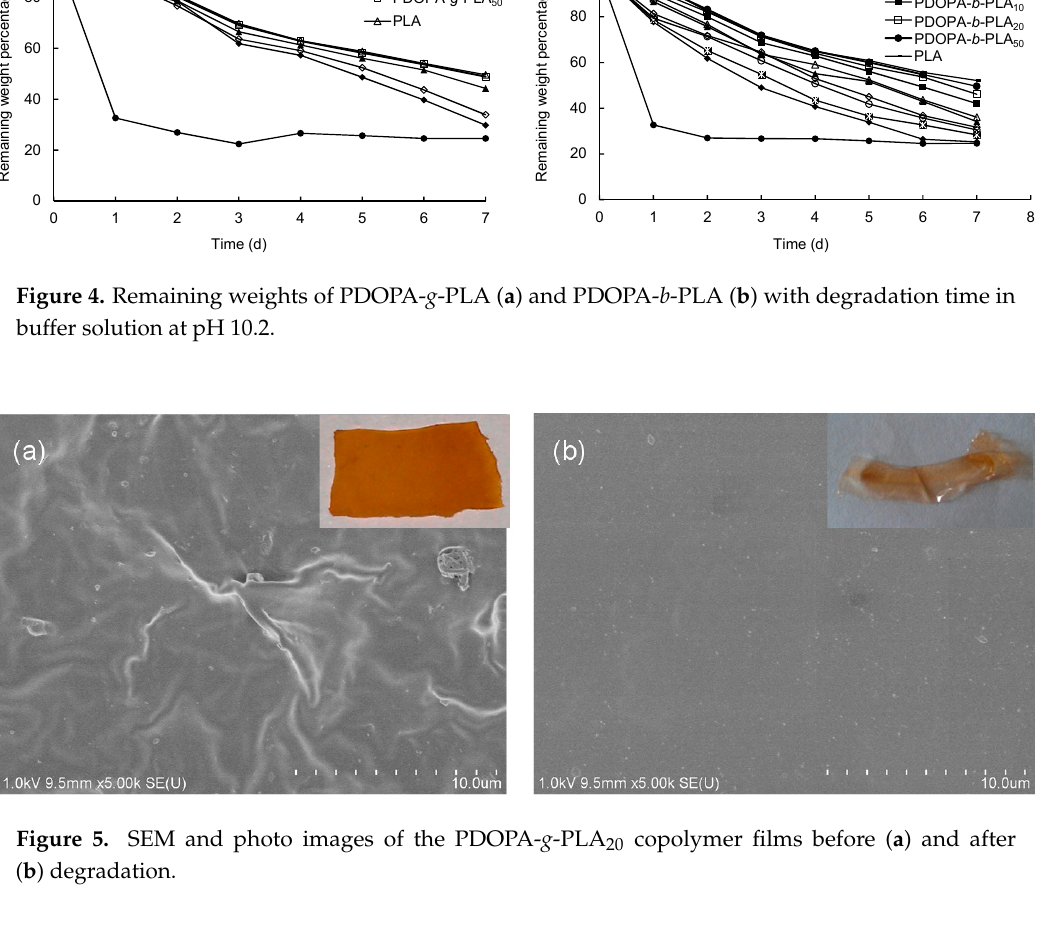
Figure 6. Fluorescence microscopy images of NIH/3T3 cells grown on the PDOPA- g -PLA 5 ( a ) and PDOPA- b -PLA 5 ( b ) copolymers. 4. Conclusions Two bio-based graft and block PDOPA- g -PLA and PDOPA- b -PLA copolymers were polymerized based on LA and DOPA. The molecular weight and composition of the copolymers could be adjusted by